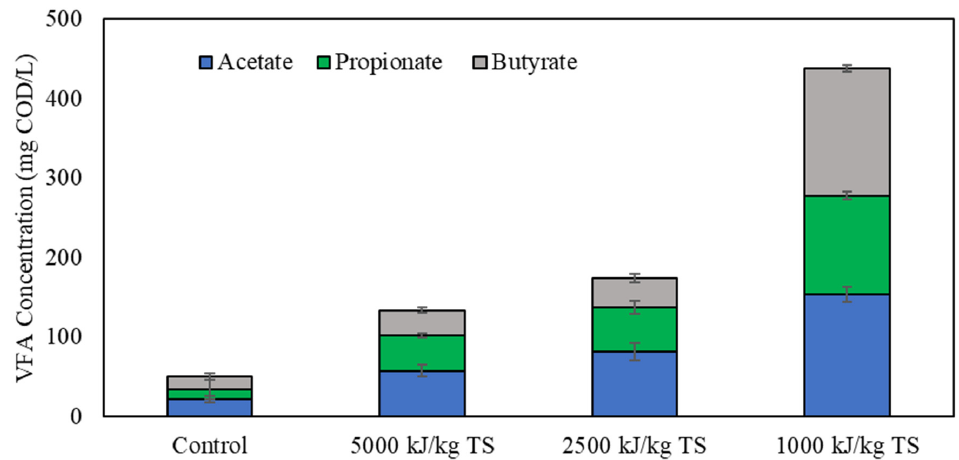
Figure 4. Changes in volatile fatty acids (VFAs) concentrations for different ultrasonication conditions.